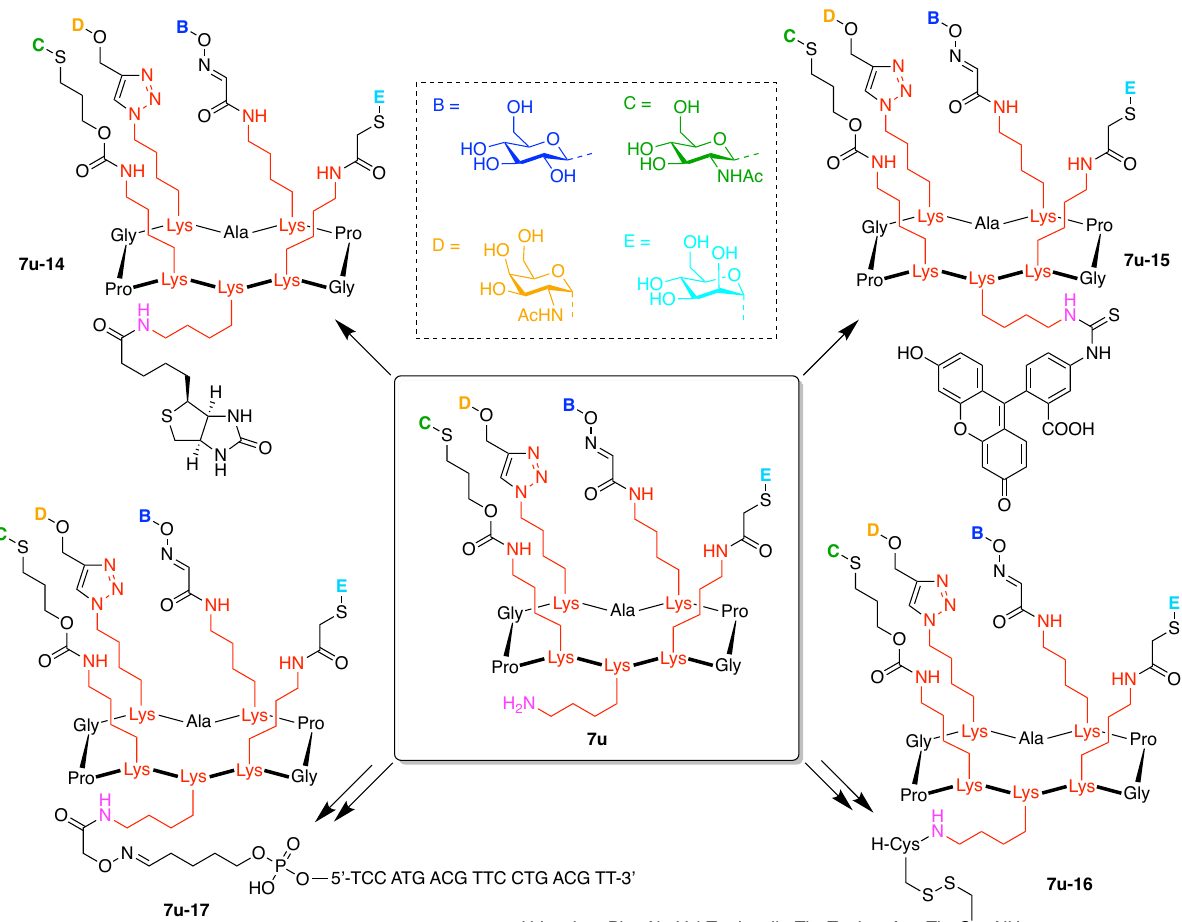
Figure 24. Decapeptide scaffold with expansive scope.